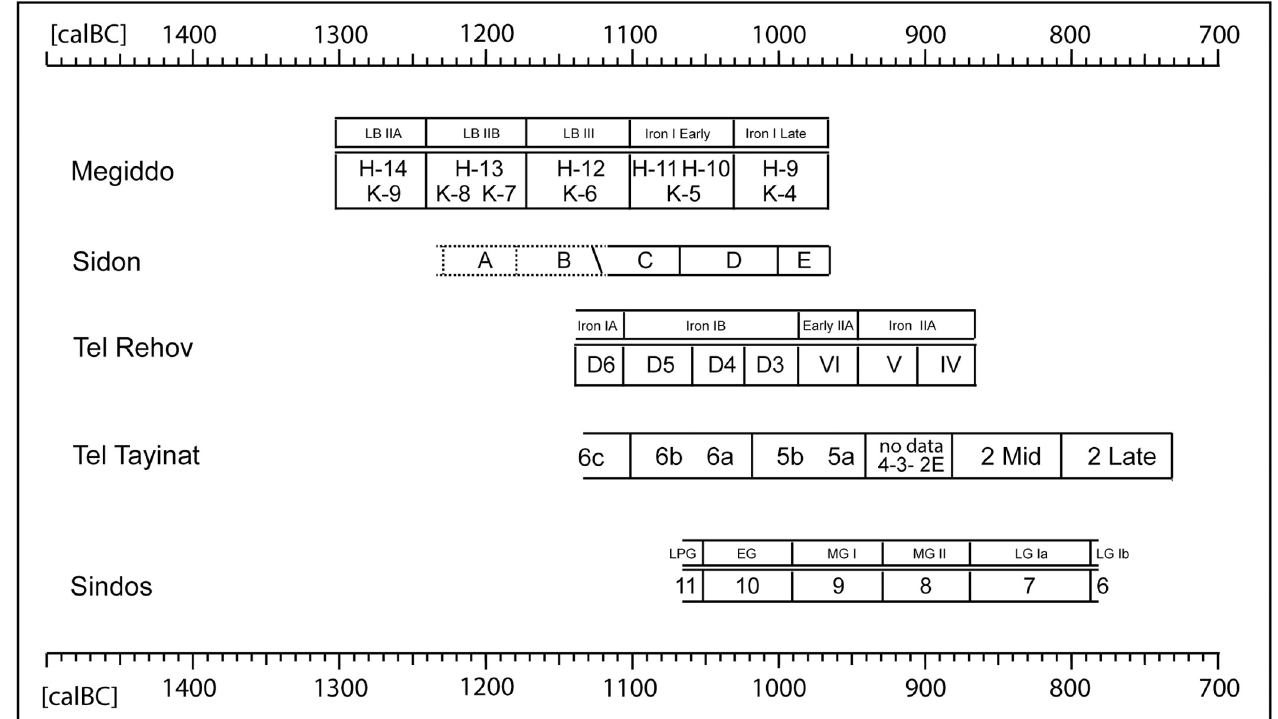
Fig 36. Comparison of the 14 C-chronologies for the study sites, based on GaussWM.